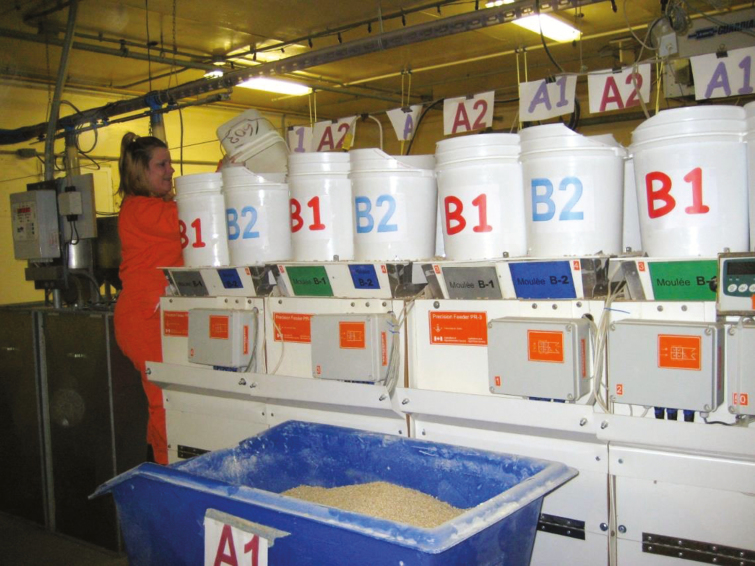
Calibrating the precision feeding mathematical model (Cloutier et al., 2015) using four feeds in each feeder. Feeds A1 (130% of lysine requirements) and A2 (70% of lysine requirements) are formulated to meet the pig’s highest lysine requirements, and B1 (130% of lysine requirements) and B2 (70% of lysine requirements) are formulated to meet the pig’s lowest lysine requirements.